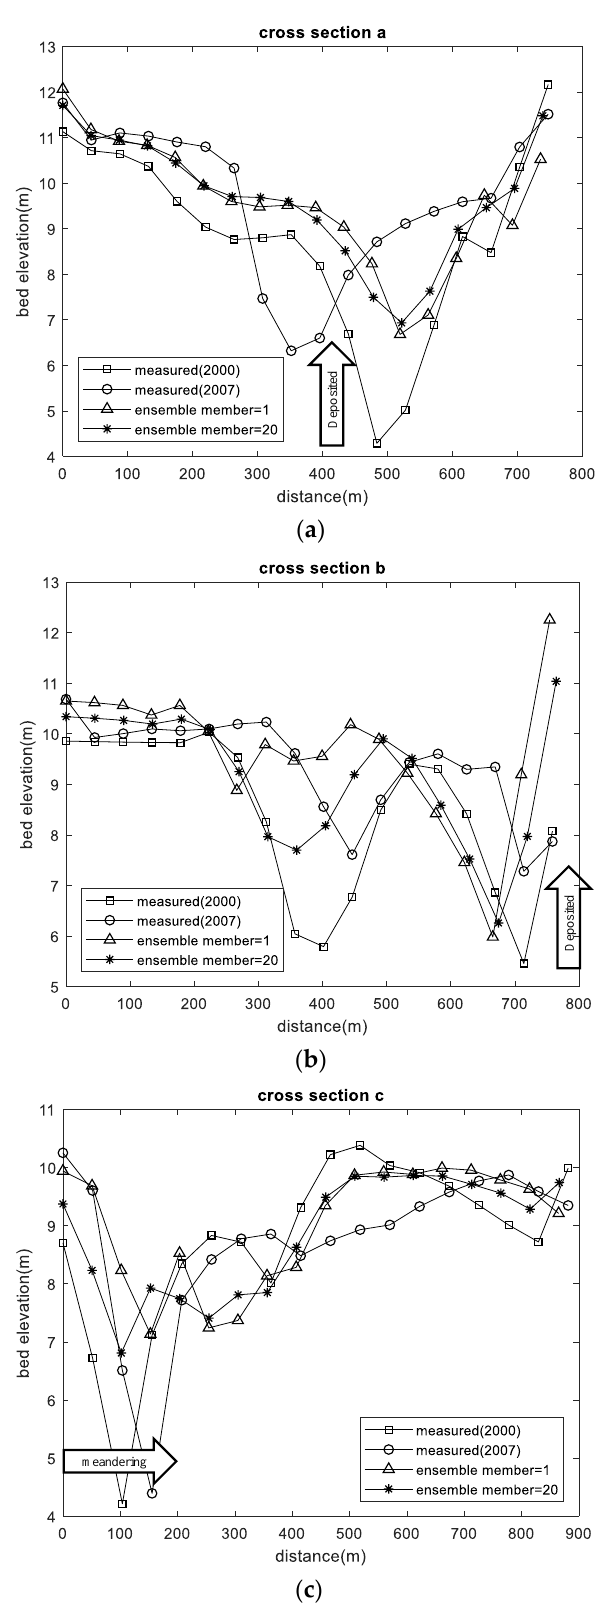
Figure 5. Comparison of the measurement and the simulation obtained from different ensemble sizes of ( a – c ) in Beigang River.